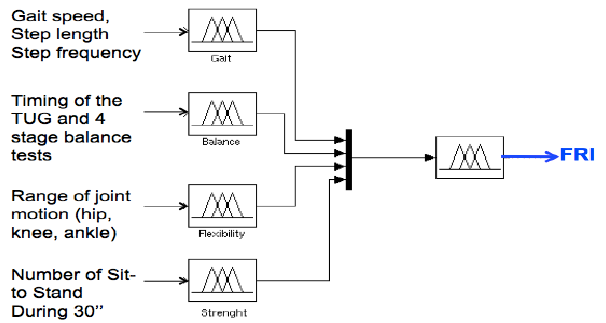
Figure 6: Schema of the